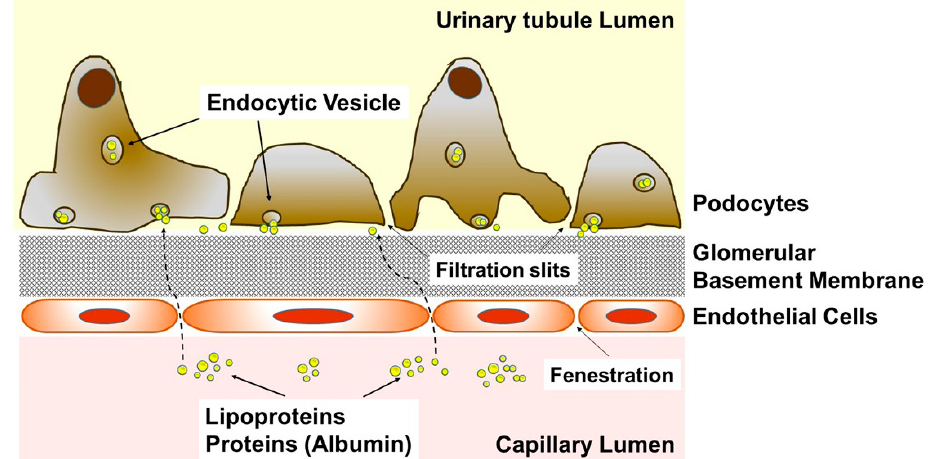
Figure 1. Cartoon depicting the microstructure of the glomerulus. Diagram showing the transfer of albumin and lipoproteins including their sphingolipid cargo from the capillary lumen through fenestration of endothelial cells to the